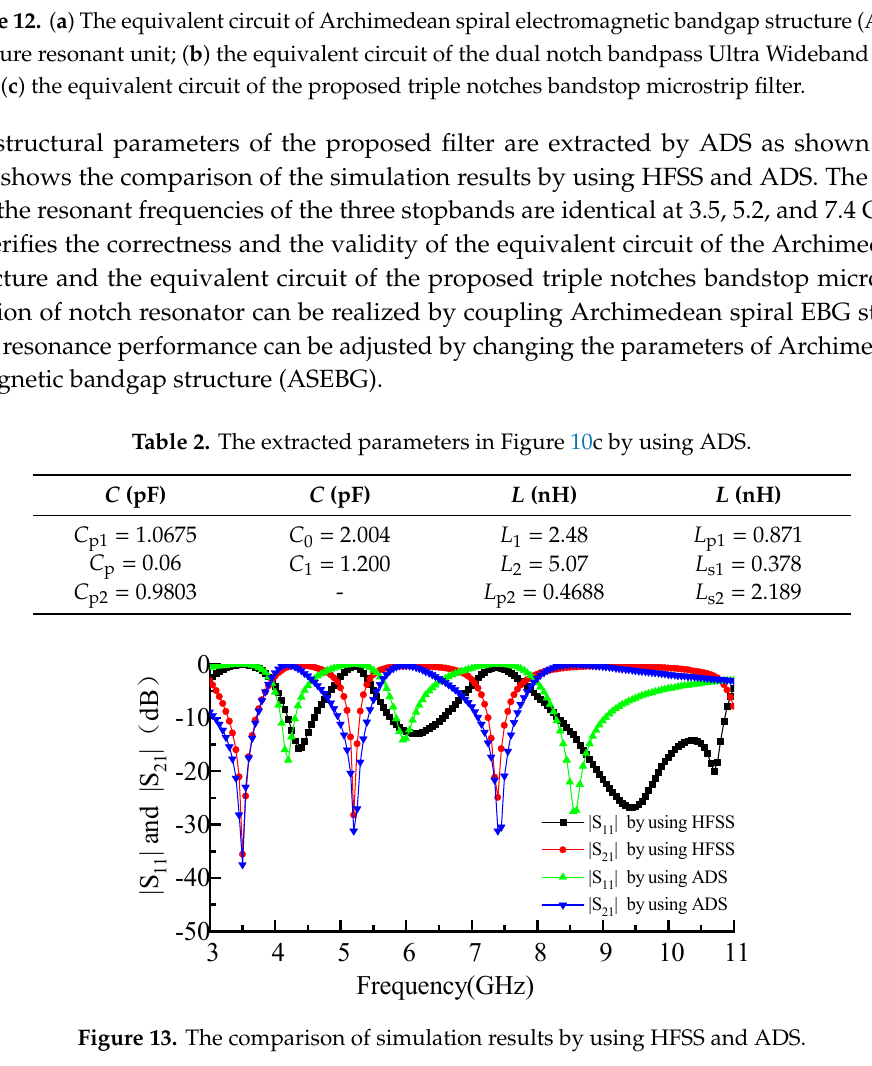
(ASEBG) structure resonant unit; ( b ) the equivalent circuit of the dual notch bandpass Ultra Wideband (UWB)